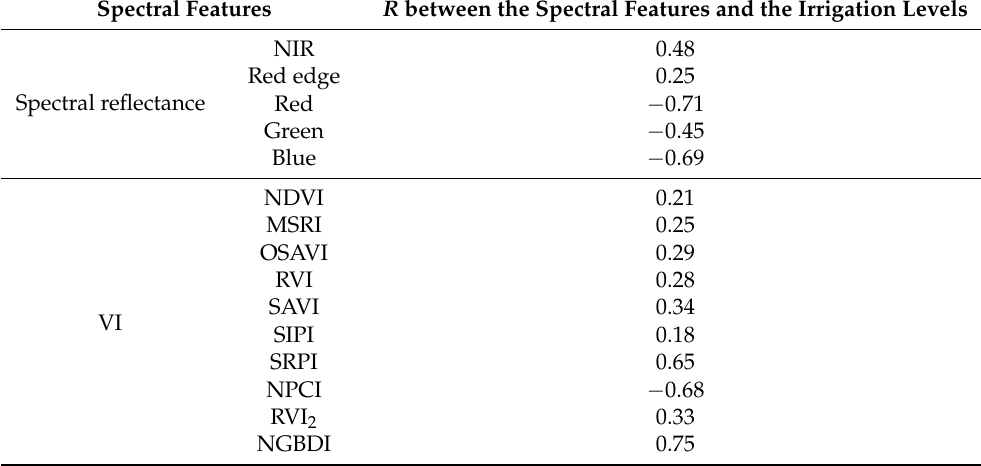
Table 9. Correlation analysis result between the spectral features and the irrigation levels. Spectral Features